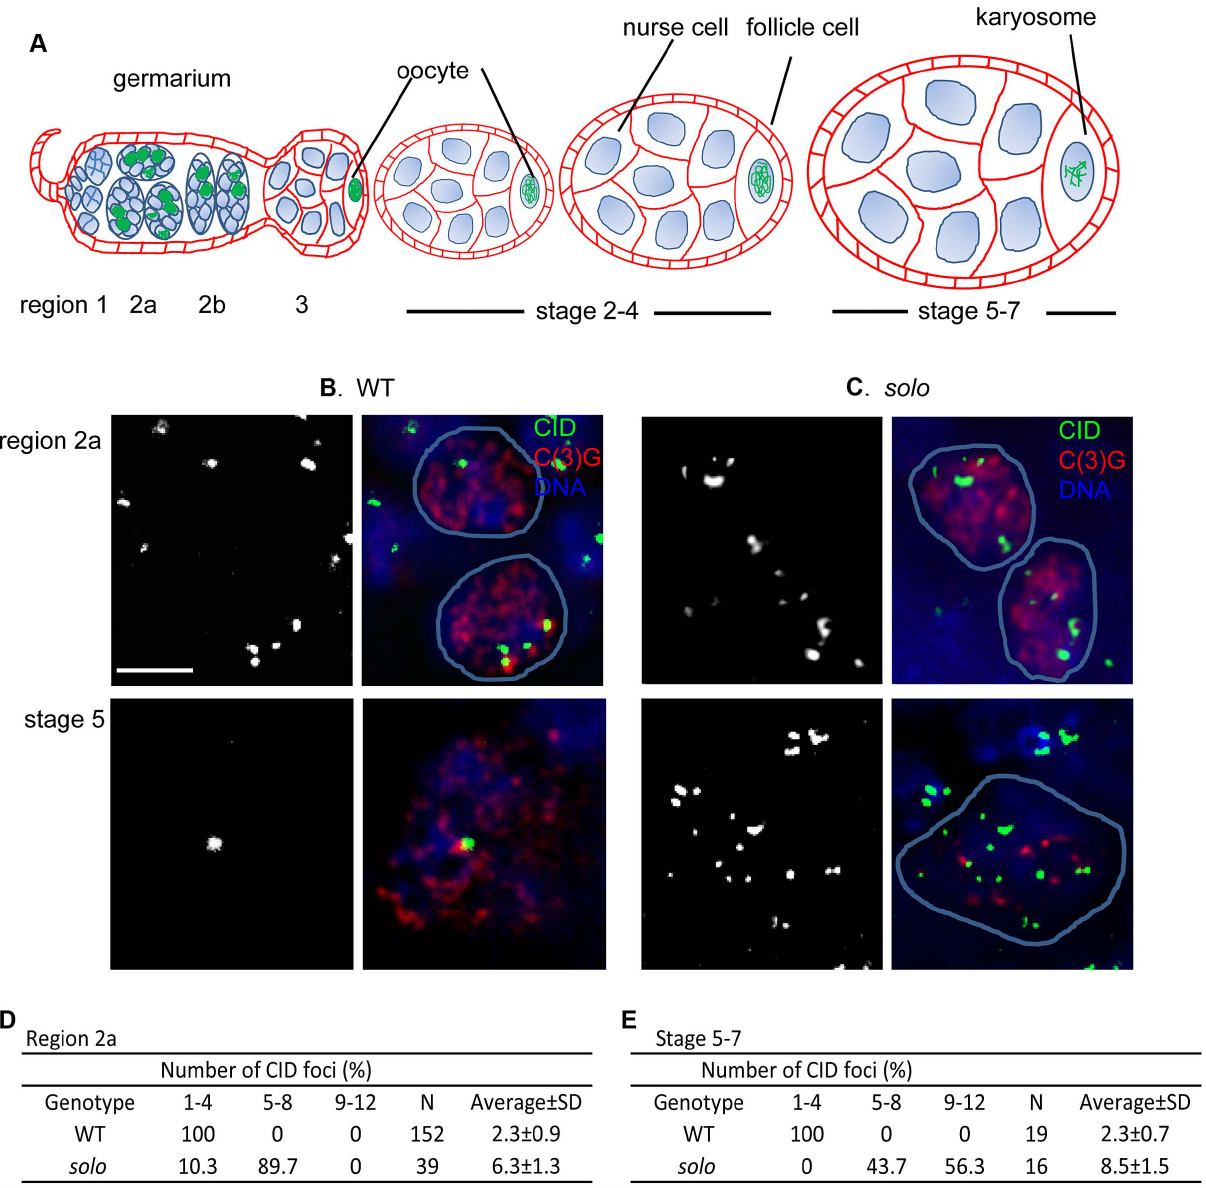
Figure 1. Centromere clustering, pairing and cohesion in solo and WT germ cells. (A) A schematic depiction of developmental stages of the germarium and early egg chambers of an ovariole [85,86]. Stages are not drawn to scale. Meiosis is initiated within the germarium, the most anterior section of each ovariole. The germarium is divided into 4 regions (1, 2a, 2b and 3, anterior-posterior). Region1 contains germline stem cells (anterior tip), cystoblasts (posterior daughters of stem cells) and mitotically proliferating 2-, 4- and 8- cell cysts. 16-cell cysts initiate meiosis in region 2a with up to 4 cells/cyst assembling SCs in zygotene while the remaining cells (pro-nurse cells) begin differentiating into nurse cells. Only two cells (the pro- oocytes) continue into meiosis and assemble full-length SC in early pachytene (still region 2a). Cysts continue moving posteriorally and by region 3, full-length SC is restricted to a single oocyte, which lies at the posterior end of the cyst. As cysts continue to grow and mature, they leave the germarium and enter the vitellarium where they are encapsulated by a single layer of somatic follicle cells to form egg chambers. The chromosomes in the oocyte begin to condense around stage 3 and SC begins to disassemble around stage 4–5. By about stage 7, SC proteins can no longer be detected on chromosome arms and the chromosomes are condensed into a compact structure called the karyosome. (B, C) Centromeres in WT and solo germ cell nuclei. Centromeres, SC and DNA were stained by anti-CID antibody (green), anti-C(3)G antibody (red) and DAPI (blue), respectively. solo : solo Z2-3534 / Df(2L)A267 . WT: sibling control. Scale bar: 5 m m. (B) 1–4 CID foci were present in WT pro-oocyte and oocyte nuclei in early (top panel) and late (bottom panel) pachytene. (C) In solo mutants, 5–8 nuclear CID foci were present in most early pachytene nuclei (top panel) and more than 8 CID foci were present in most late pachytene nuclei (bottom panel). (D, E) Percentages of nuclei with indicated numbers of CID foci in pro-oocytes from region 2a (D) and in oocytes from stage 5–7 egg chambers (E). N=number of nuclei scored. doi:10.1371/journal.pgen.1003637.g001 protein Venus. UPS-SOLO::Venus ( UPS-SOLO ) is driven by native GAL4-responsive UAS sequences [53]. Both transgenes were able regulatory sequences carried in a 2.7 Kb fragment of upstream to complement the NDJ phenotype of a null solo allele but the UAS-SOLO construct did so more robustly (Table S1). A single genomic DNA. UASp-Venus::SOLO ( UAS-SOLO ) is controlled by